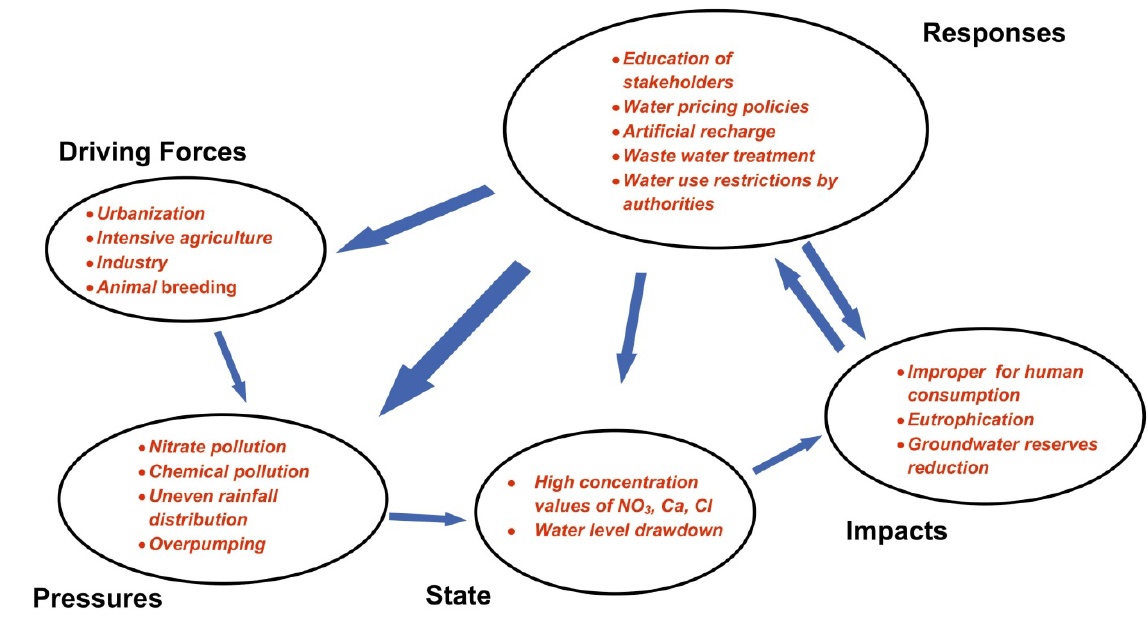
Figure 2. A generic DPSIR framework for water resources of Gallikos River basin (illustrated by the authors based on the framework of Kristensen